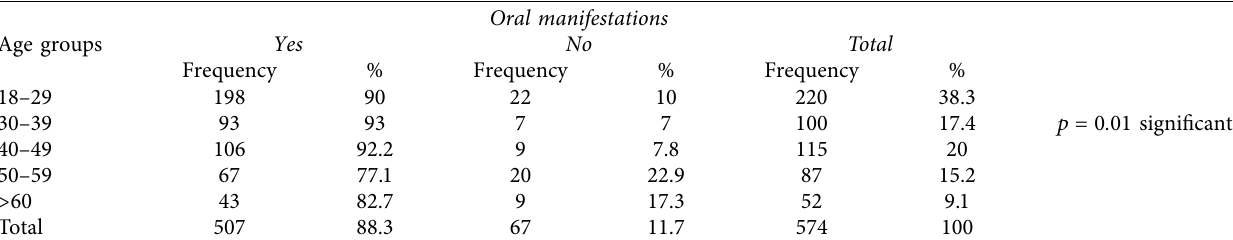
Table 2: Frequency, percentage, and the statistical diference of occurrence of oral symptoms in COVID-19 patients according to the age